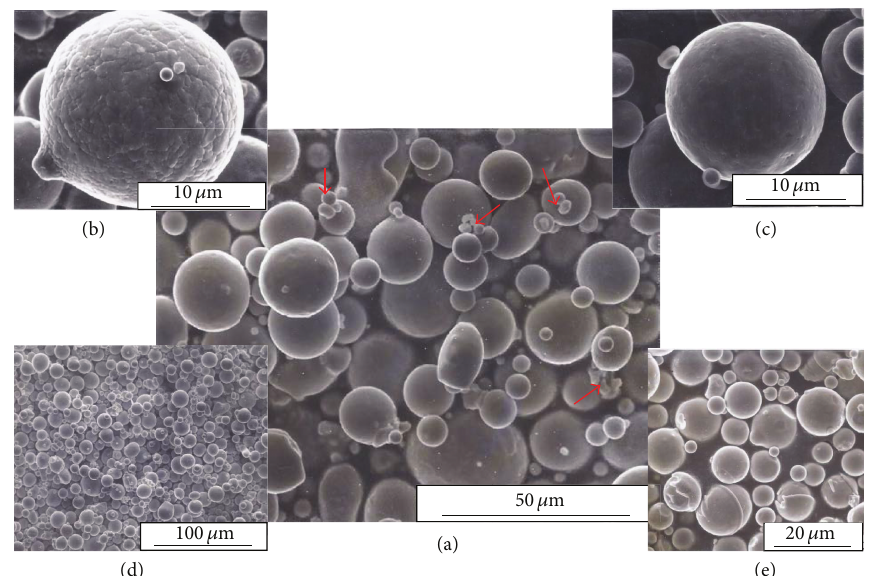
Figure 1: The (a) SEM surface microstructure of Cu-Sn alloys as the red arrows points to the semisolid tin during the electroless process, (b) the graphite particle, (c) the lead particle as uniform spherical shape, (d) Cu-Sn alloys with graphite particles, and (e) Cu-Sn alloys with lead particles during the electroless process.